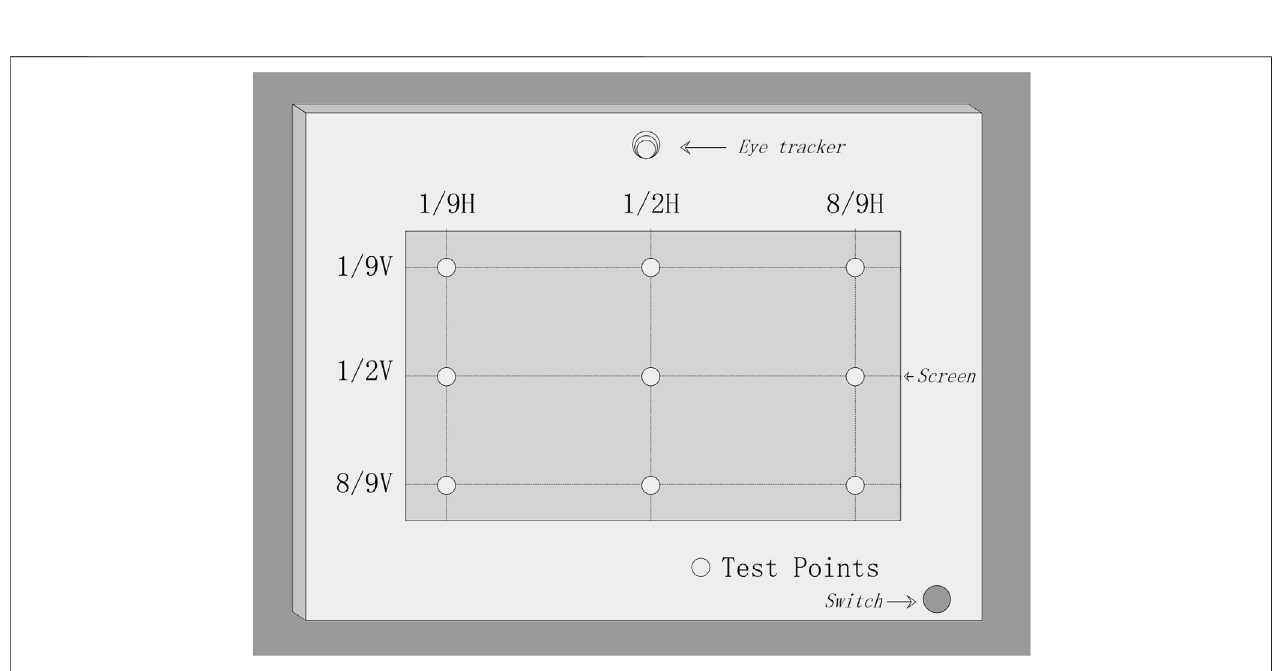
FIGURE 2 | Distribution diagram of the nine observation points on the screen selected to measure the brightness of the autostereoscopic display.